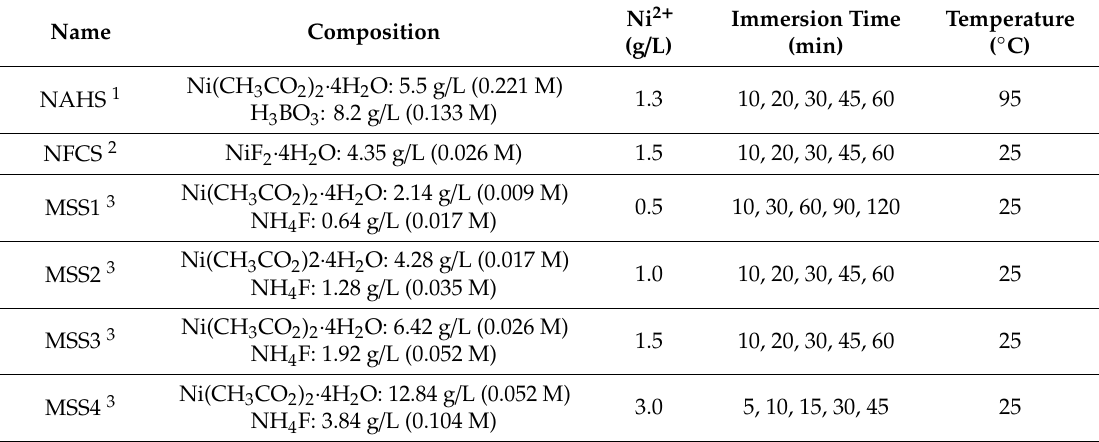
Table 1. Experimental conditions for the sealing of anodic aluminum